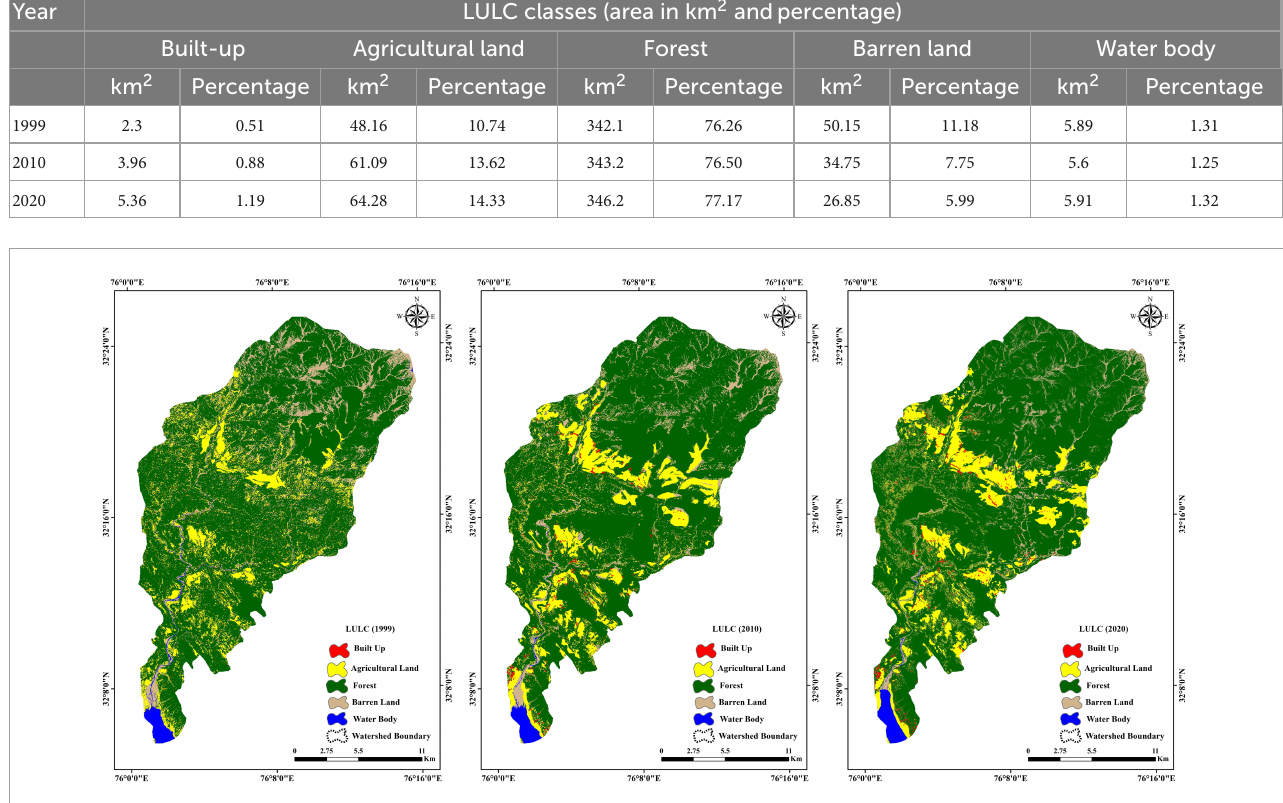
FIGURE7 Showing LULC maps for the years 1999, 2010, and 2020 of the Dehar watershed.